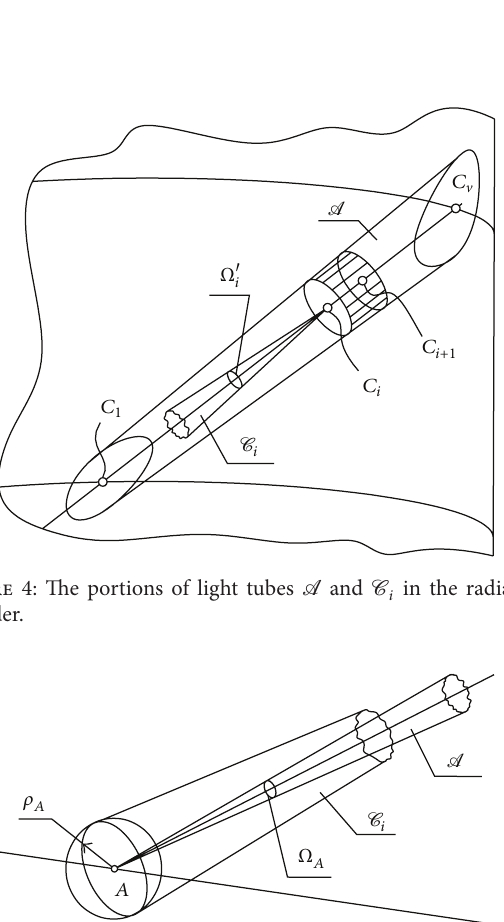
Figure 5: The portions of light tubes A and C 𝑖 near sphere (𝐴,𝜌 𝐴 )